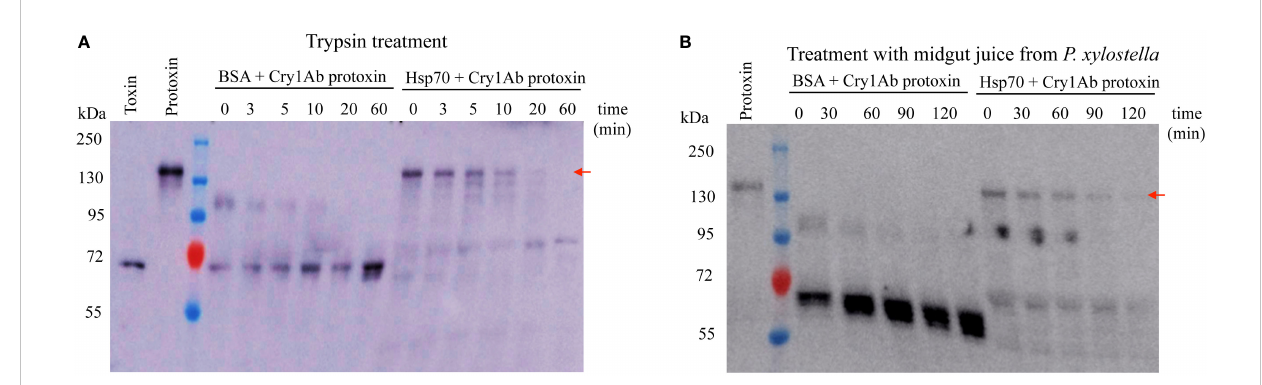
FIGURE 1 PxHsp70 protects Cry1Ab protoxin from protease degradation. (A) Trypsin treatment (1:40 w:w) of one m g Cry1Ab protoxin for different time points in the presence of either BSA or PxHsp70 and revealed by western blot using anti-Cry1Ab antibody. (B) Treatment of Cry1Ab protoxin with midgut juice from P. xylostella as described in methods. One m g Cry1Ab protoxin was treated with the midgut proteases for different time points in the presence of either BSA or PxHsp70 and revealed by western blot using anti-Cry1Ab antibody. Representative results of three replicas are shown. The arrows indicate the position of the 130 kDa Cry1Ab